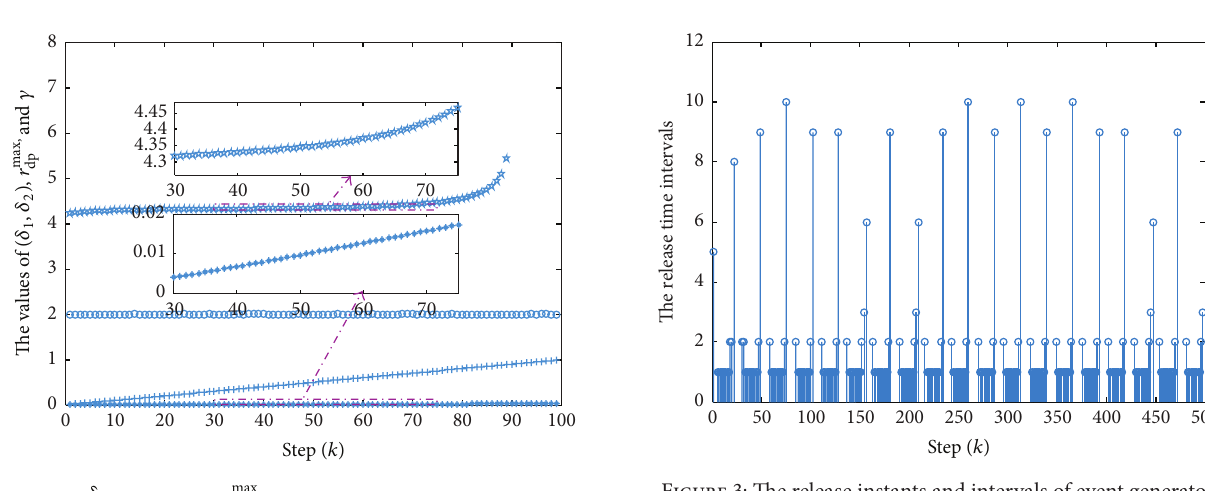
Figure 3: The release instants and intervals of event